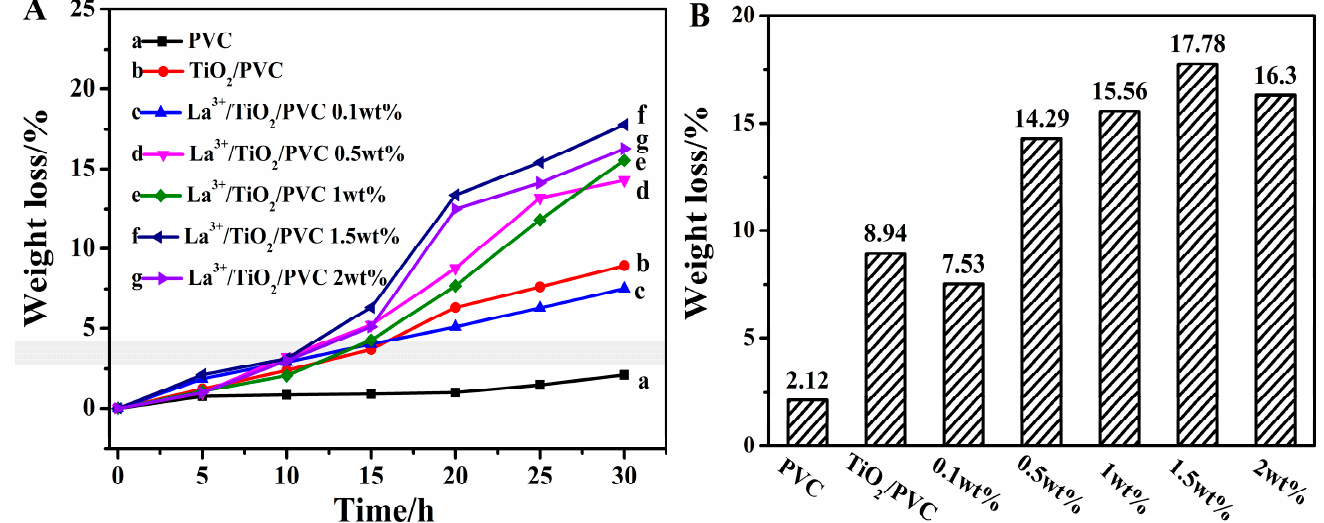
Figure 5. ( A ) Curves of weight loss of degradation process. (a) Pure PVC sample, (b) TiO 2 /PVC sample, (c) La 3+ /TiO 2 /PVC (La 3+ /TiO 2 0.1 wt%), (d) La 3+ /TiO 2 /PVC (0.5 wt%), (e) La 3+ /TiO 2 /PVC (1 wt%), (f) La 3+ /TiO 2 /PVC (1.5 wt%), (g) La 3+ /TiO 2 /PVC (2 wt%). ( B ) Maximum weight loss rate.